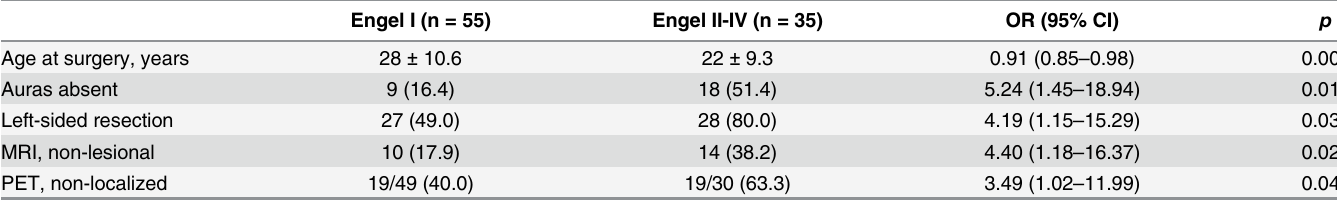
Table 4. Prognostic factors of seizure outcomes 1 year after surgery. Engel I (n = 55) Engel II-IV (n = 35) OR (95% CI) p Age at surgery, years 28 ± 10.6 22 ± 9.3 0.91 (0.85 – 0.98) 0.008 9